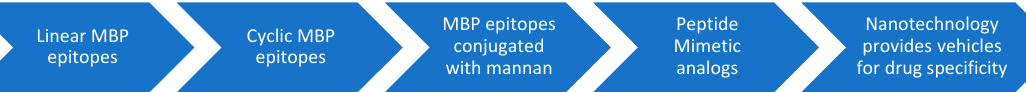
Figure 8. The most promising non-peptide inhibitors derived from in silico studies proved to have bioactivity against EAE.